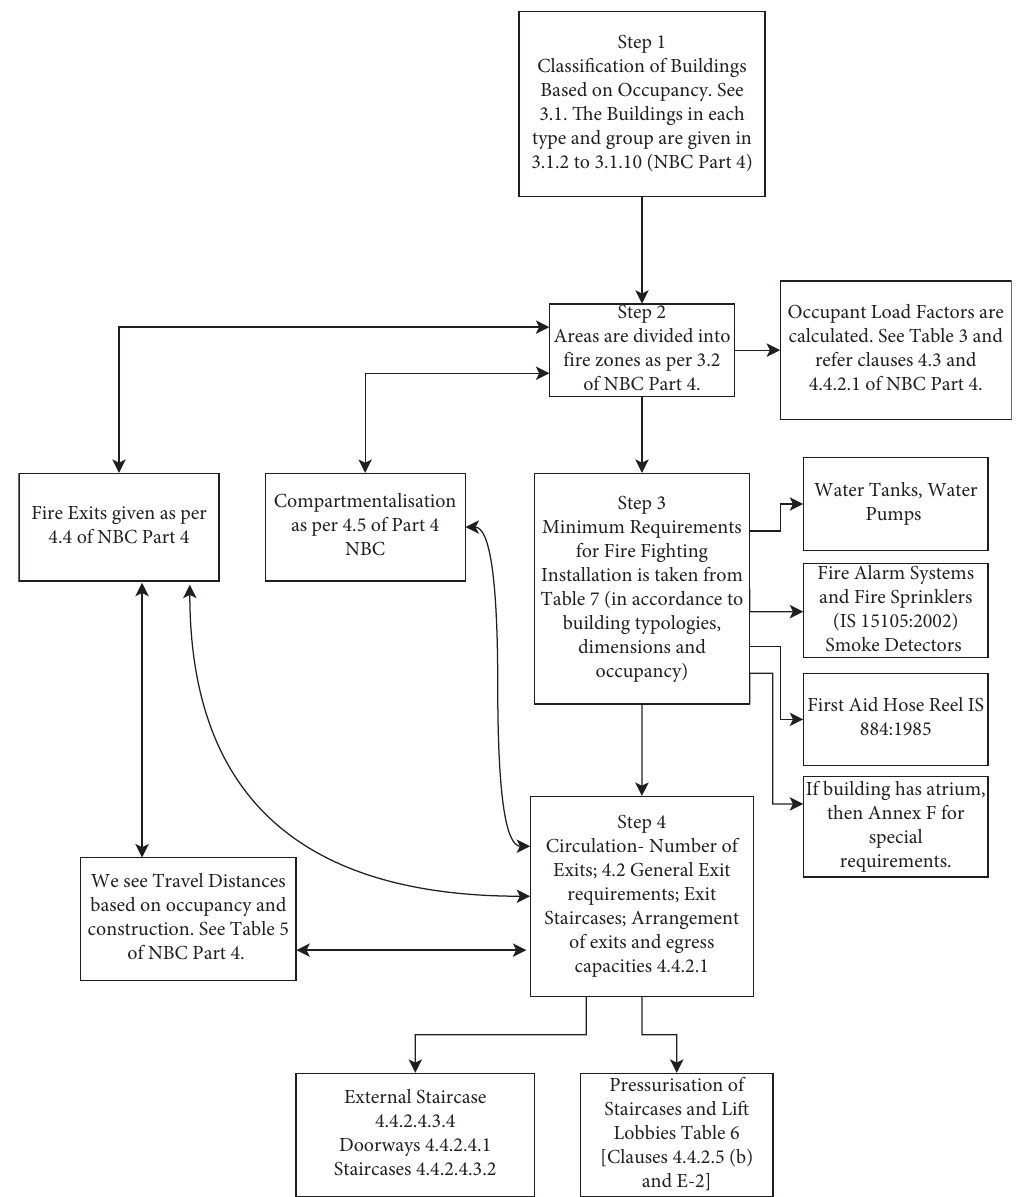
Figure 1: A corrected version of an easy graphical list prepared by a class student creates a list of actionable steps in order. Tese steps have been derived from NBC 2016, Part 4 Fire and Life